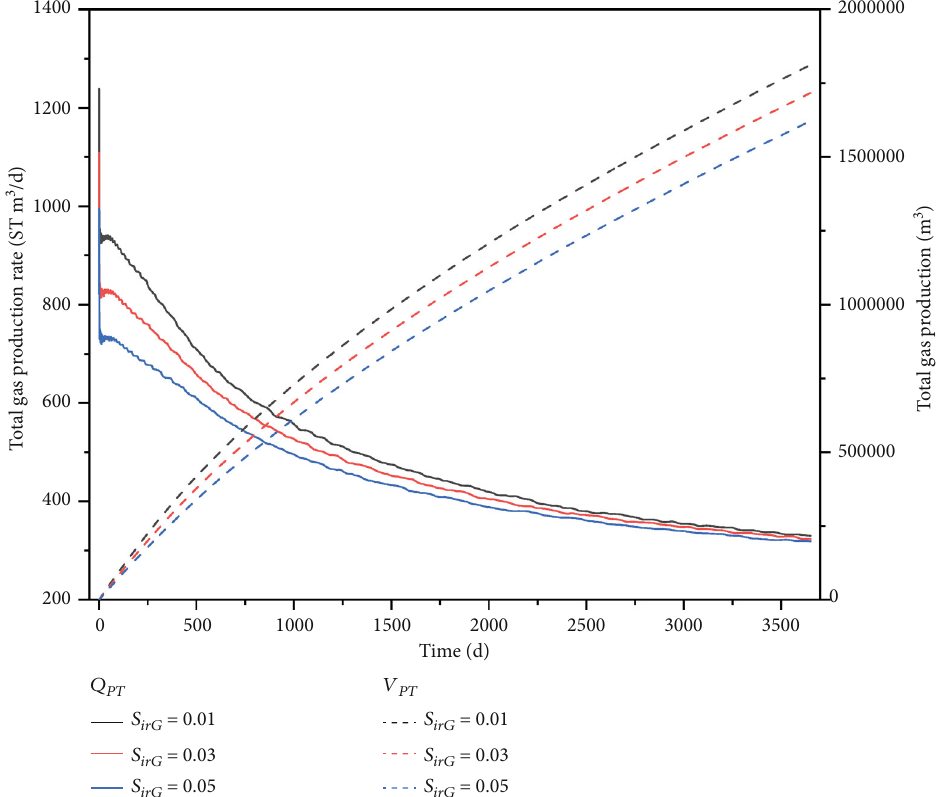
Figure 12: Evolution of total gas production rate Q